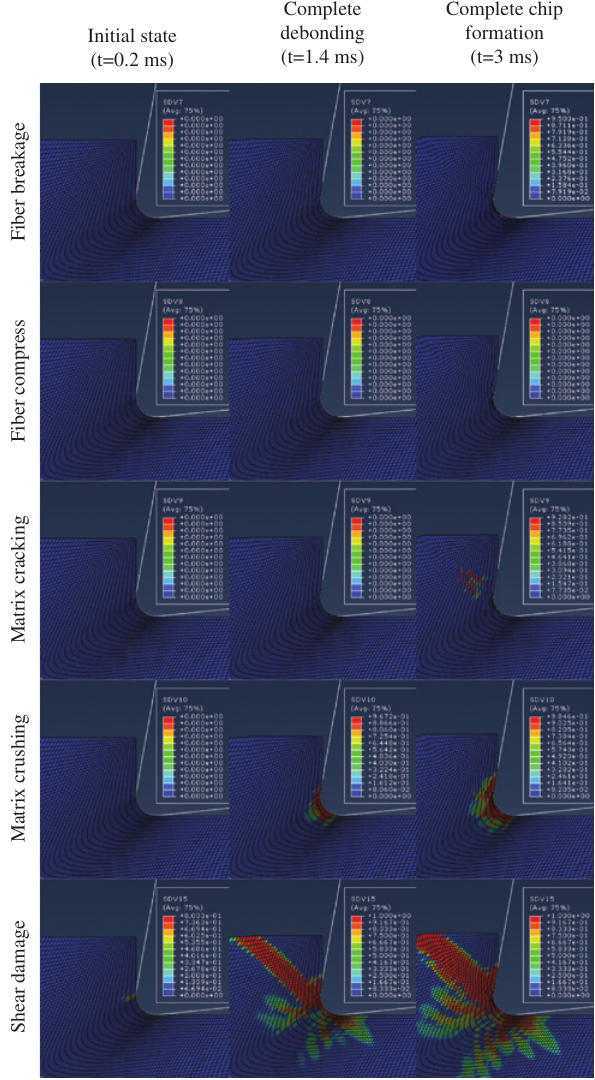
Figure 6: Damages during chip formation for Maximum stress- progressive damage (fiber orientation 45 °